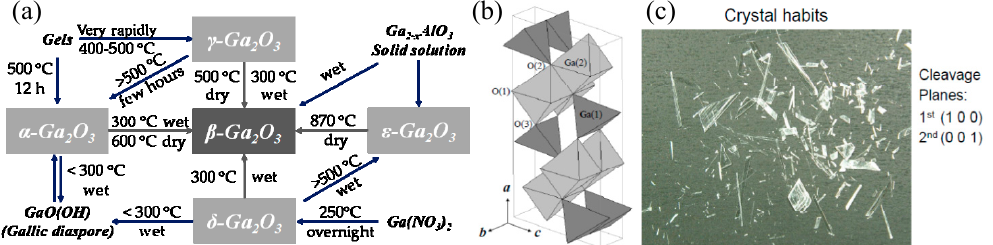
Figure 1. ( a ) Transformation relationships among Ga 2 O 3 in different crystalline phases and their hydrates. ( b ) Structural schematic illustration of the β -Ga 2 O 3 unit cell, manifesting the two gallium locations and three oxygen locations. ( c ) Cleavage nature of single crystal β -Ga 2 O 3 . Reprinted with permission from reference [64]. Copyright 2014 SPIE.